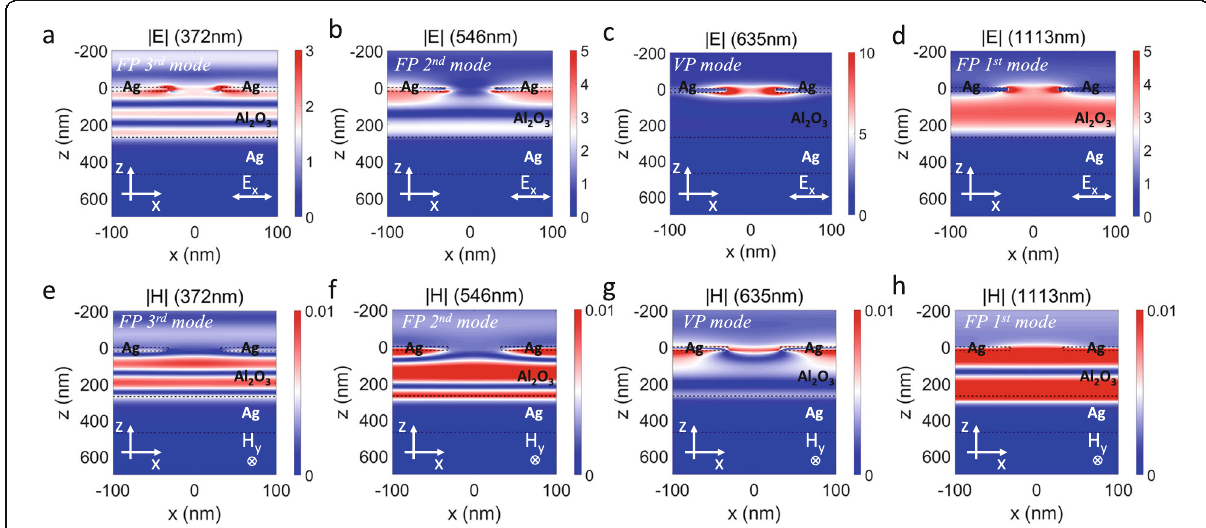
Fig. 4 Calculated spatial field distributions of electric ( a – d ) and magnetic ( e – h ) fields for normal light incidence. The wavelength of incident light is 372 nm ( a , e ), 546 nm ( b , f ), 635 nm ( c , g ), and 1113 nm ( d , h ). The black dash lines denote the cross section of the structure. Here, the parameters of the structure are set as p = 200 nm, w = 60 nm, h 1 = 20 nm, h 2 = 250 nm, h 3 = 200 nm, and ε 2 =